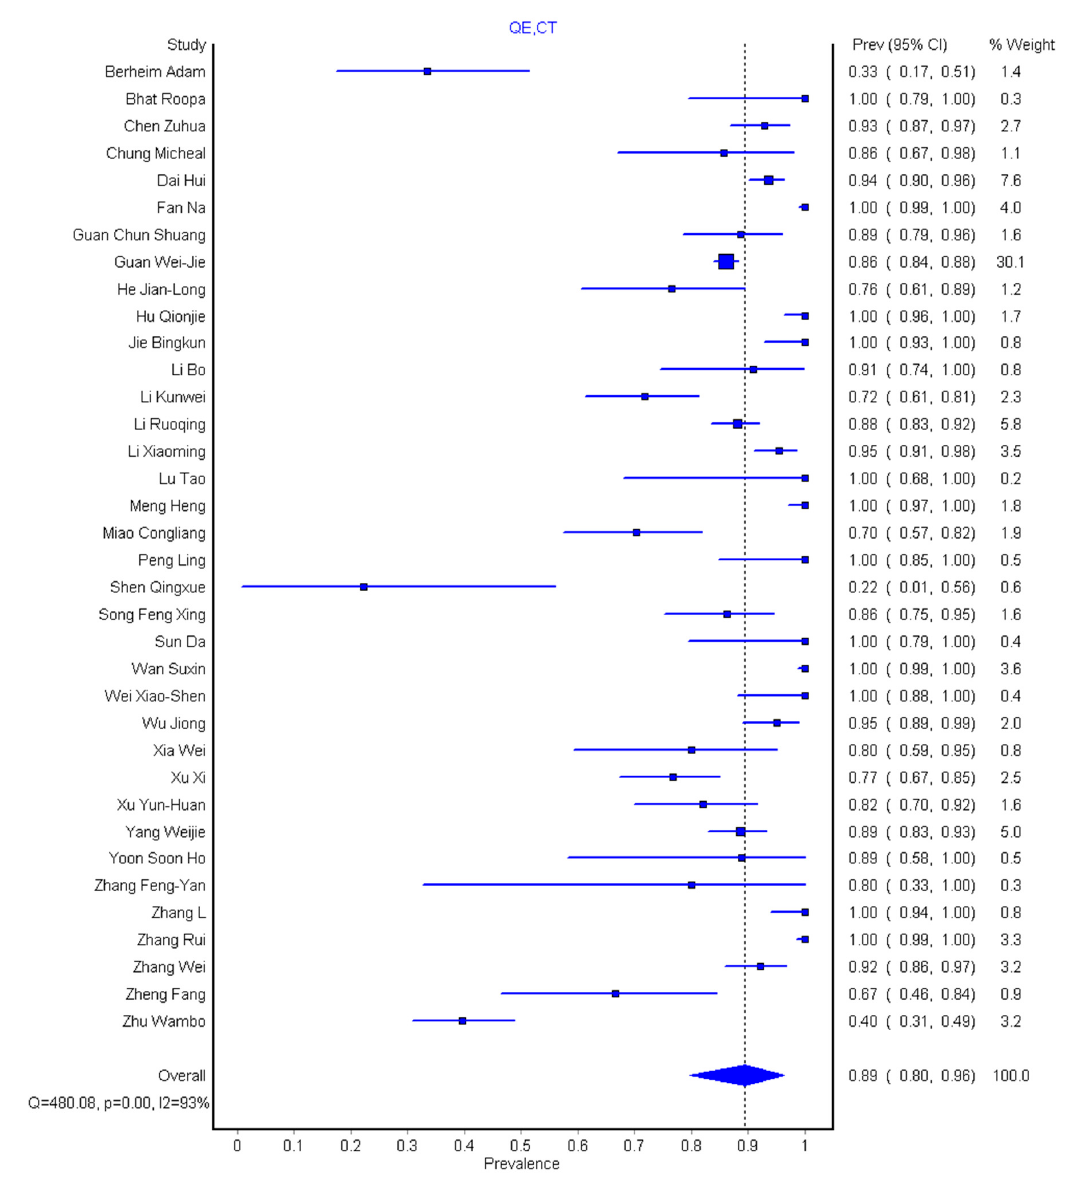
Figure 2. Forest plot of the pooled sensitivity of chest CT for detection of coronavirus disease 2019 (COVID-19) infection.